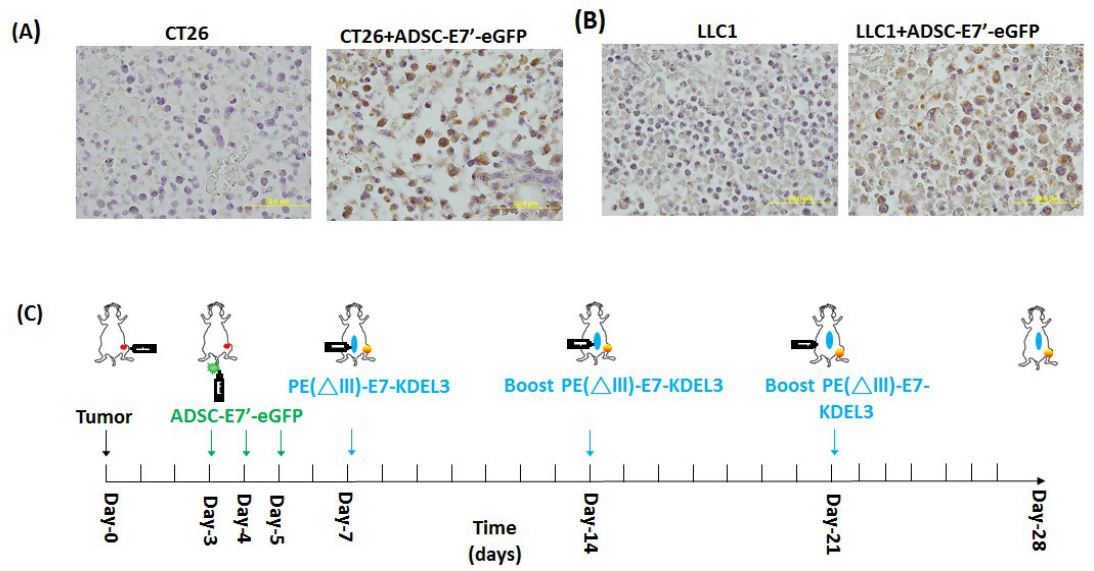
Figure 3. Cont Figure 3. Count.